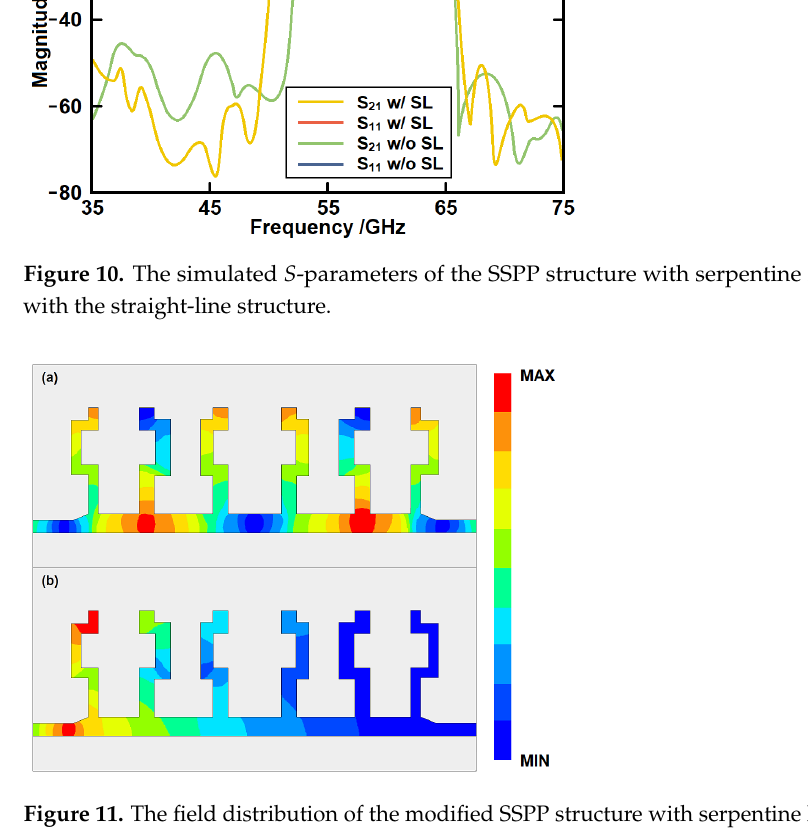
Figure 11. The field distribution of the modified SSPP structure with serpentine lines at ( a ) passband and ( b )